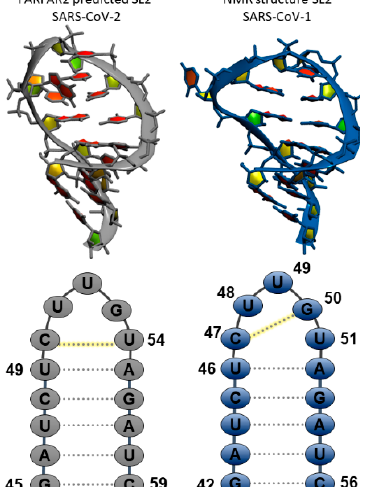
Figure 1. Comparison of predicted stem loop 2 (SL2) structures from ( left ) de novo tertiary structure prediction Fragment Assembly of RNA with Full-Atom Refinement (FARFAR2) and ( right ) NMR structure for SL2 in Severe acute respiratory syndrome coronavirus 1 (SARS-CoV-1). Sequences with global numbering and deviations in the secondary structure preferences are highlighted in the bottom frames.